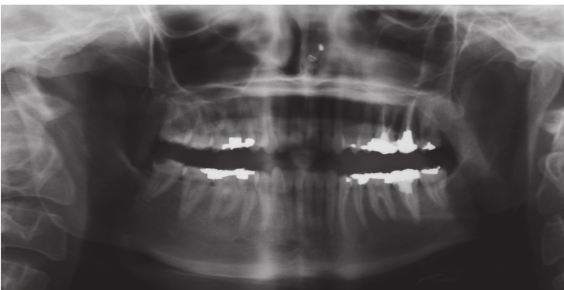
Figure 1: Panoramic radiograph of the patient’s dental condition on day 15 of first